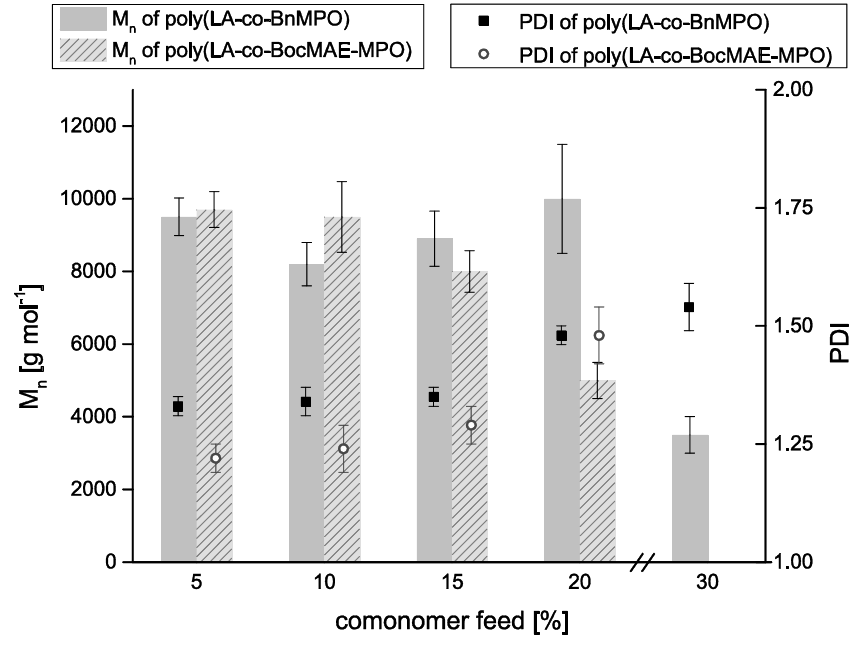
Figure 3. M n (columns) and PDI (squares and circles) of synthesized copolymers dependent on comonomer